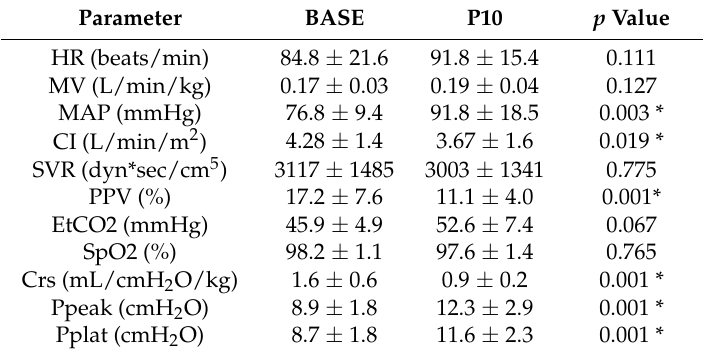
Table 2. Mean ± SD of the cardiovascular and respiratory parameters evaluated 5 min before (BASE) and 10 min after (P10) the pneumoperitoneum (PP) in twenty mechanically ventilated isoflurane-anesthetized dogs. * p < 0.05 between the two evaluation times of the study.